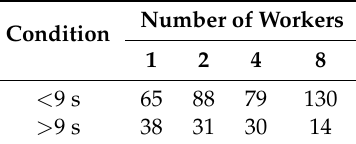
Table 8. Number of messages sent before and after 9